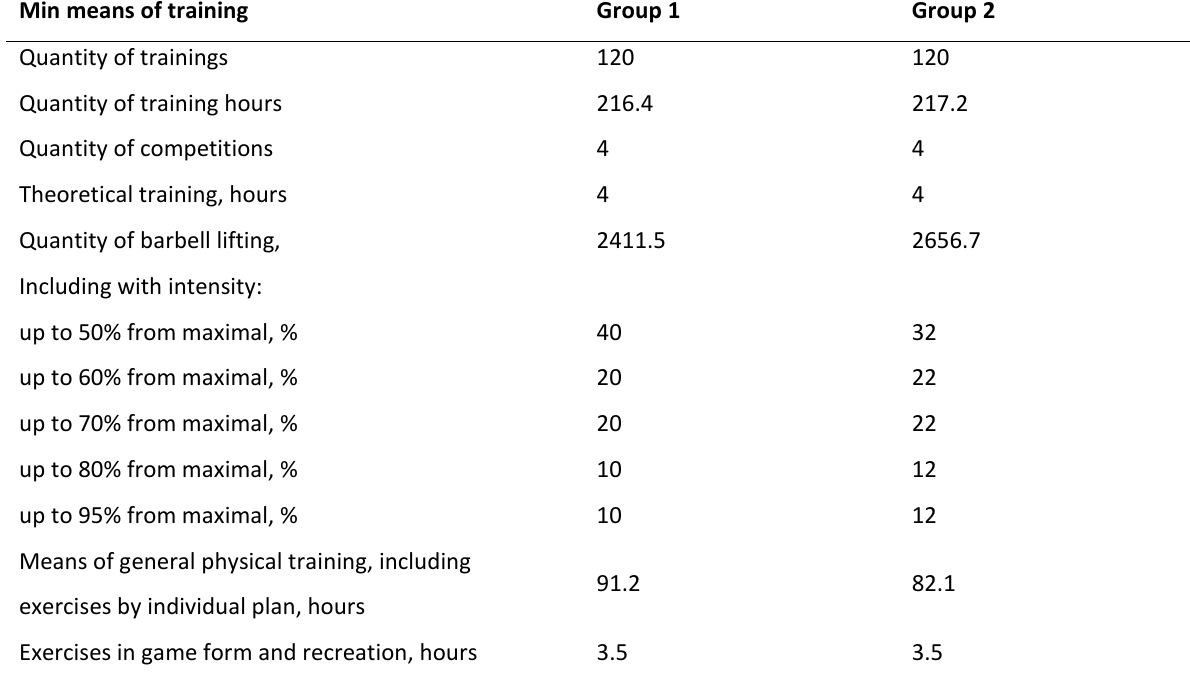
Table 1. Year volumes of main training means of 1 st year students – power lifters in group 1 and 2. Min means of training Group